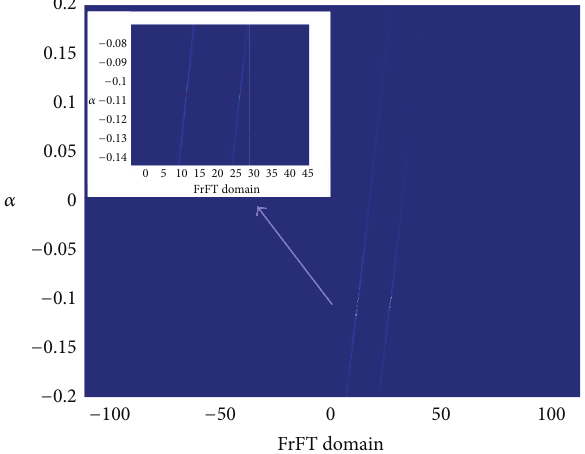
Figure 5: The variance values of different subregions in frac- tional Fourier domain. The environment is SNR = − 15 dB and SRR = − 15dB. There are two moving targets: one is located at [1450, 1550] m with velocity being [4, 5] m/s; the other is located at [1600, 1500] m with velocity being [5, 4.5]